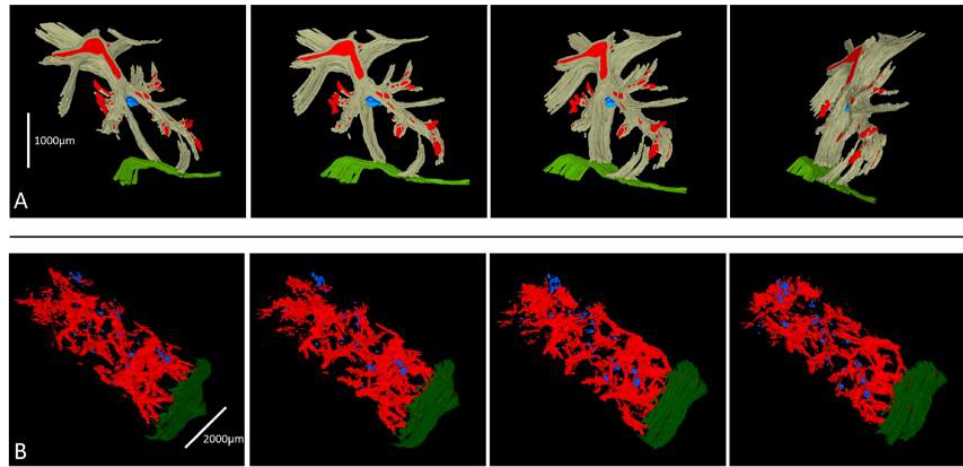
Figure 6. Three-dimensional reconstruction of two HT lesions. ( A ) The first HT lesion is shown as a blue nodular area resting against the convergence of two fibro-connective vascularized (red) septa (grey) and well away from the capsule (green). The second HT lesion ( B ) is shown as multiple blue lesional foci aligned on an oblique axis to the liver capsule plane (green). Vasculature is in red.